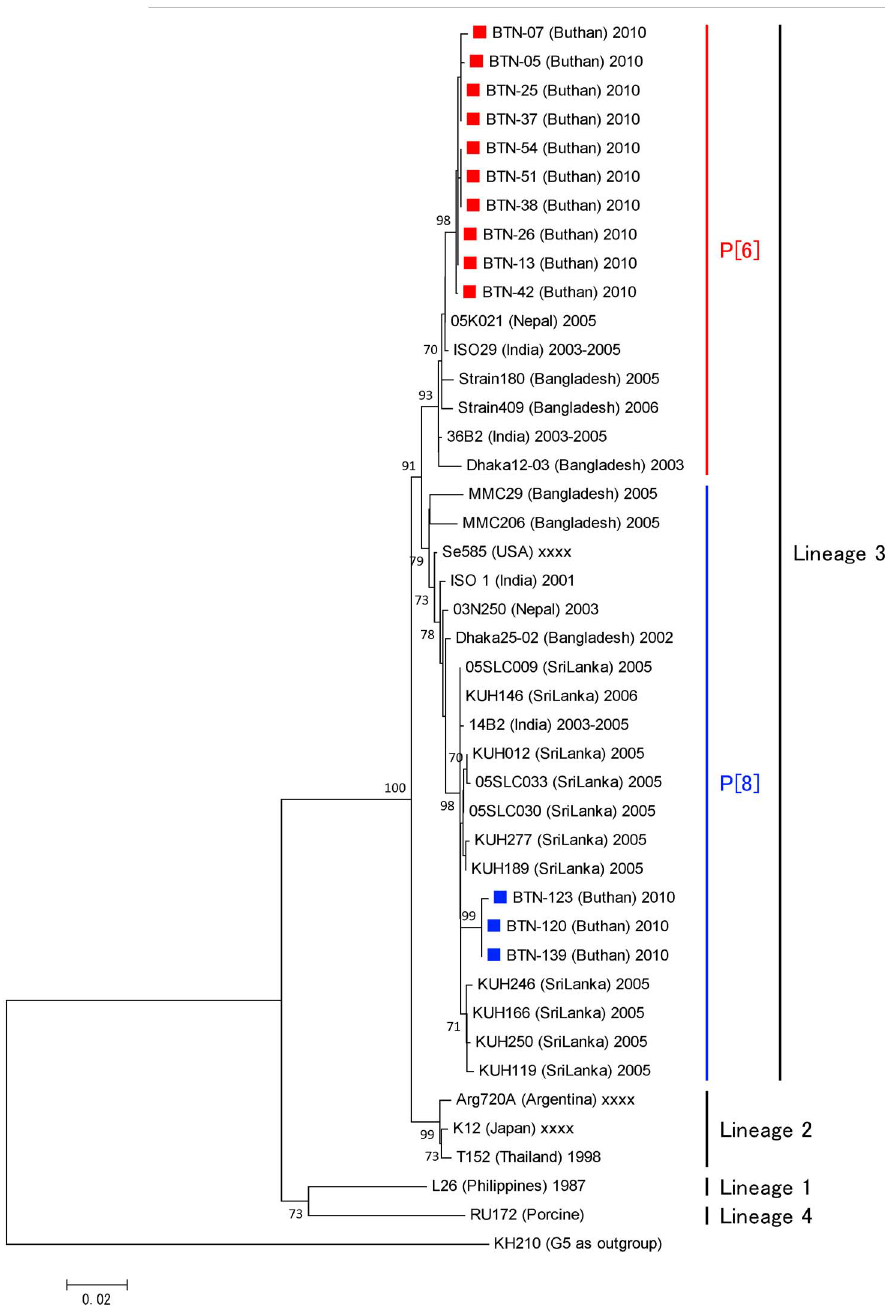
Figure 5. Phylogenetic tree constructed based on the deduced amino acid sequences of the VP7 gene of G12 strains. Bhutanese strains are indicated by black squares, which are followed by the strain numbers. Human rotavirus KH210 (G5) was used as an outgroup. The numbers adjacent to nodes represent the bootstrap values; values , 70% are not shown. The scale bar shows the genetic distance, which is expressed as amino acid substitutions per site. The DNA Data Bank of Japan/European Molecular Biology Laboratory/GenBank accessions numbers are: AB905467 (rotavirus strain BTN-05), AB905468 (BTN-07), AB905469 (BTN-13), AB905470 (BTN-25), AB905471 (BTN-26), AB905472 (BTN-37), AB905473 (BTN-38), AB905474 (BTN-42), AB905475 (BTN-51), AB905476 (BTN-54), AB905477 (BTN-120), AB905478 (BTN-123), and AB905479 (BTN-139). doi:10.1371/journal.pone.0110795.g005 in 38 samples (Figure 1). The frequencies of the G1, G9, and G12 genotypes were 26 (59.1%), five (13.4%), and 13(29.5%), respectively. The relative detection rates for different combinations of G and P genotypes were in the following order: G1P[8] = 21 (47.7%), G12P[6] =10 (22.7%), G9P[8] = 5 (11.3%), G1P[4] = 5 (11.3%) and G12P[8] = 3 (6.8%).